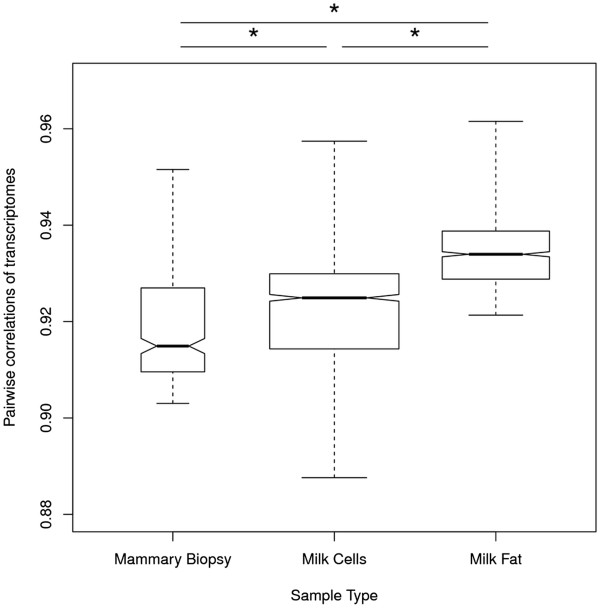
Transcriptome homogeneity within sample types. Transcriptomes derived from samples of the same type (mammary biopsy, milk cells, or milk fat) were compared with other samples of the same type using a Spearman’s correlation. The boxplot summarizes the findings by sample type. The upper and lower bounds of each box denote the first and third quartiles of the data, the dark horizontal line within each box denotes the median value, and the whiskers extend to the minimum and maximum values. The width of each box is proportional to the square root of the samples size. Asterisks denote statistical significance (p < = 0.05).